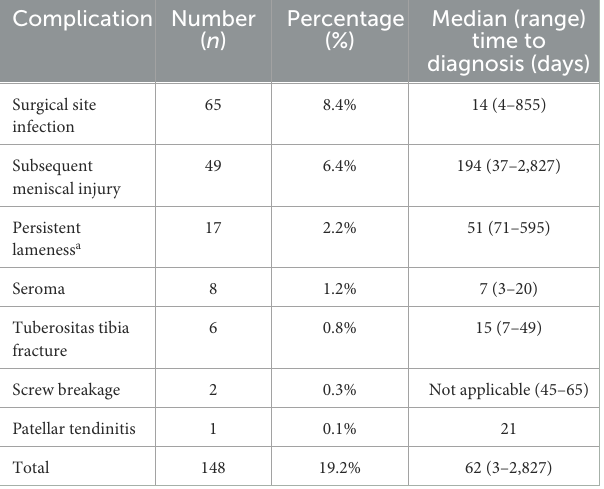
TABLE 3 Overview of postoperative complications of 769 Tibial Plateau Leveling Osteotomies.